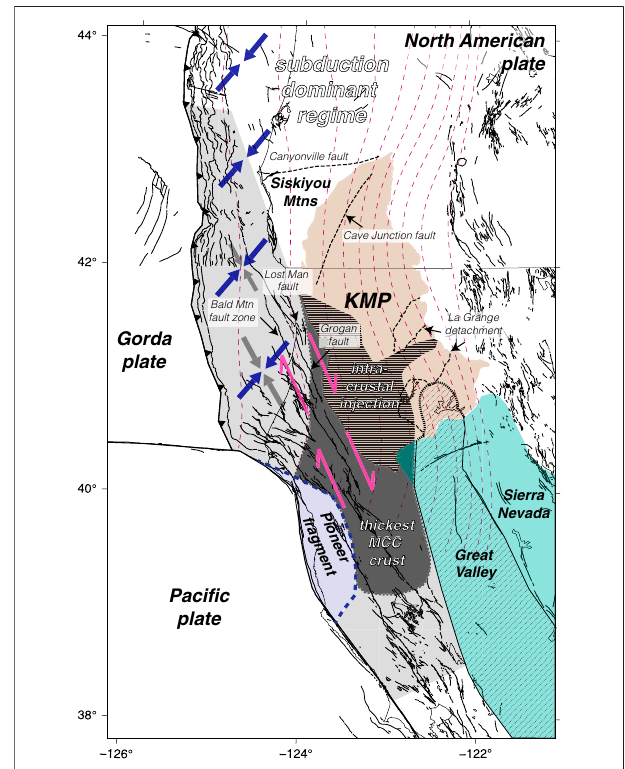
FIGURE 11 | Summary map showing the tectonic setting, geographic regions, and key tectonic processes acting in the study region that produce upper-plate deformation of the North America plate. North of ~43 ° N subduction-coupling is the dominant tectonic process acting to deform the upper plate. The light grey shaded region shows the approximate N-S extent of the MCC process on the upper plate. The dark grey shading shows the region of the highest crustal thickness within the MCC corridor, outlined based on the 20 km depth tomography imagery. The horizontal dashed region within the KMP, shows the approximate extend of the Franciscan crustal material injected into the KMP at mid-crustal levels. The Pioneer fragment is shaded in light blue. The teal shaded region is the SNGV block. The dotted lined region within the SNGV block shows the approximate extent of the Great Valley ultrama fi c body at mid-crustal